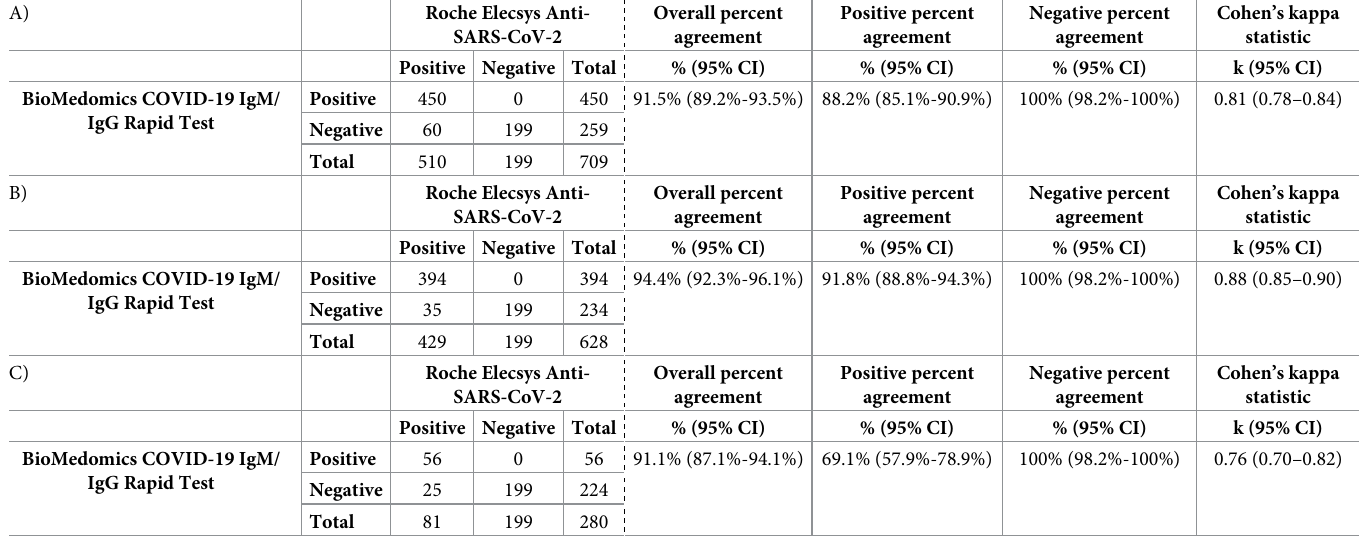
Table 2. Concordance metrics between two SARS-CoV-2 antibody assays: The BioMedomics COVID-19 IgM/IgG Rapid Test and the Roche Elecsys Anti-SARS- CoV-2 including A) all negative and positive specimens, B) negative specimens on Elecsys and specimens with higher Elecsys antibody titers (excluding specimens with Elecsys optical density values < 10), and C) negative specimens on Elecsys and specimens with lower Elecsys antibody titers (excluding specimens with Elecsys optical density values �